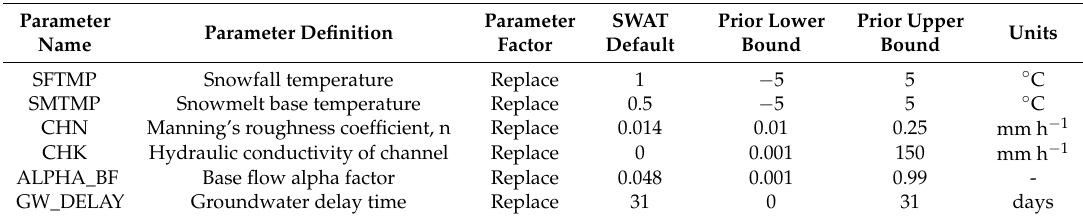
Table 2. Parameters’ name, description, and units, default value on Soil and Water Assessment Tool (SWAT) and range used for prior